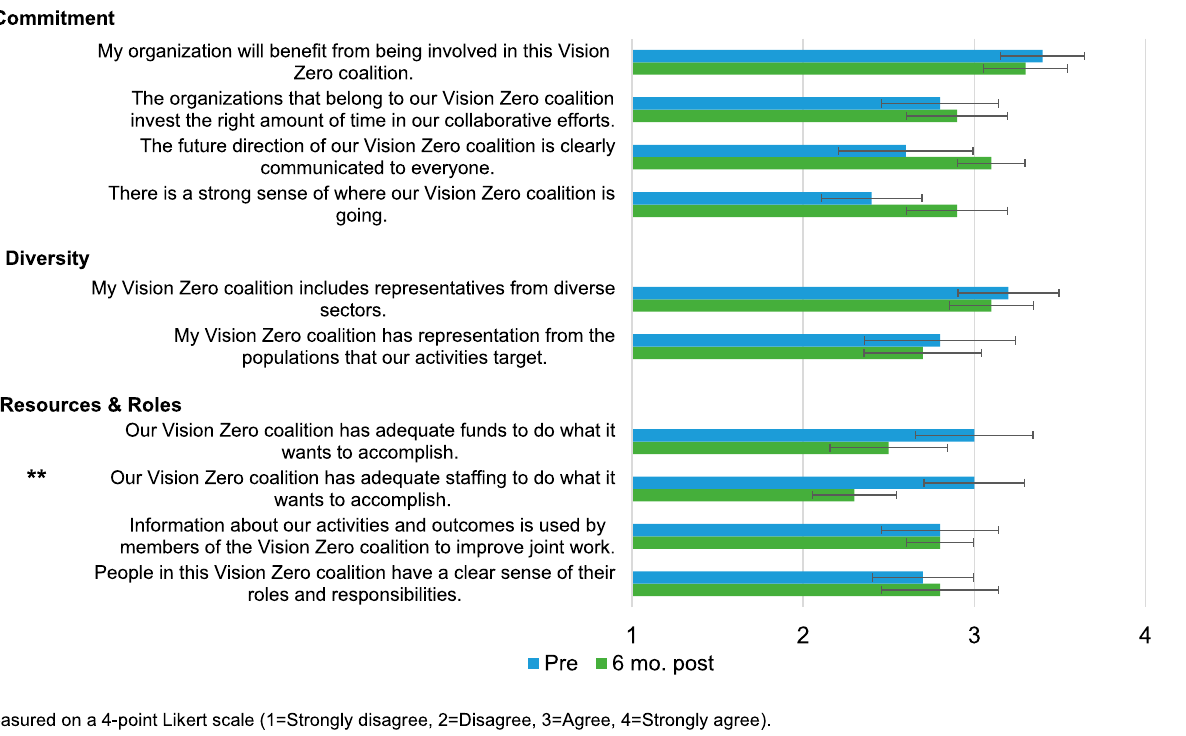
FIGURE 2 Changes* in perceived coalition commitment, diversity, and resources between Vision Zero Leadership Institute and 6-month post-assessment.